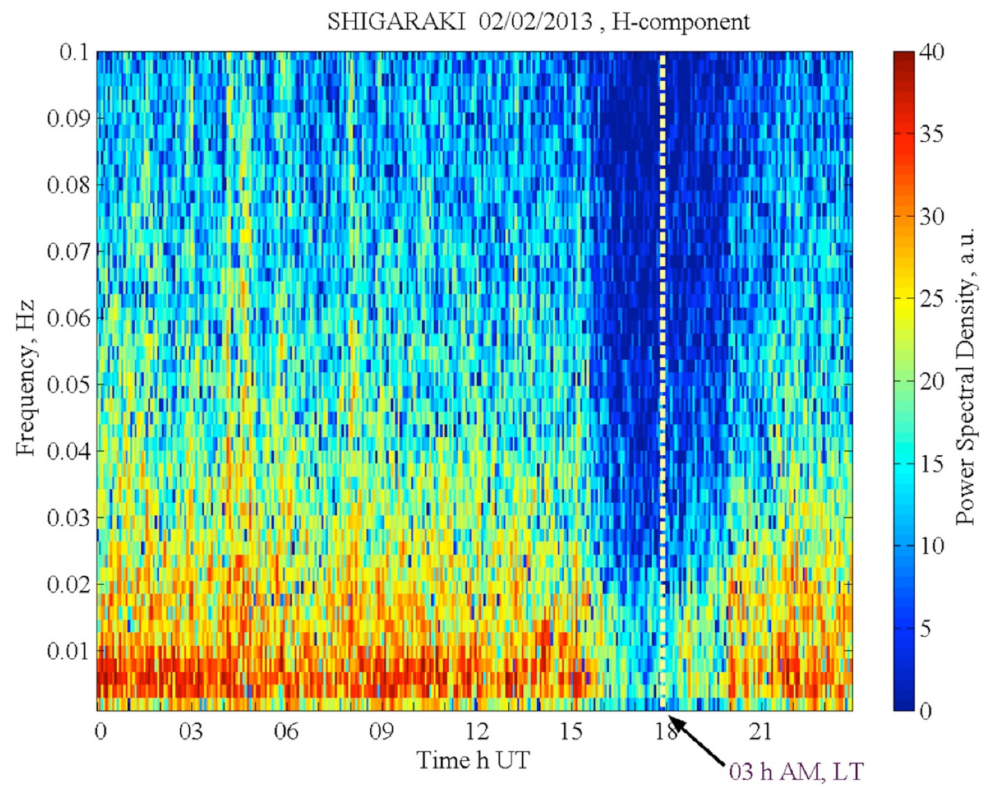
Figure 2. Indicative background electromagnetic activity at the ground-based station of Shigaraki: Daily spectrum (power spectral density) on February 2, 2013, for the H-component recorded at the specific